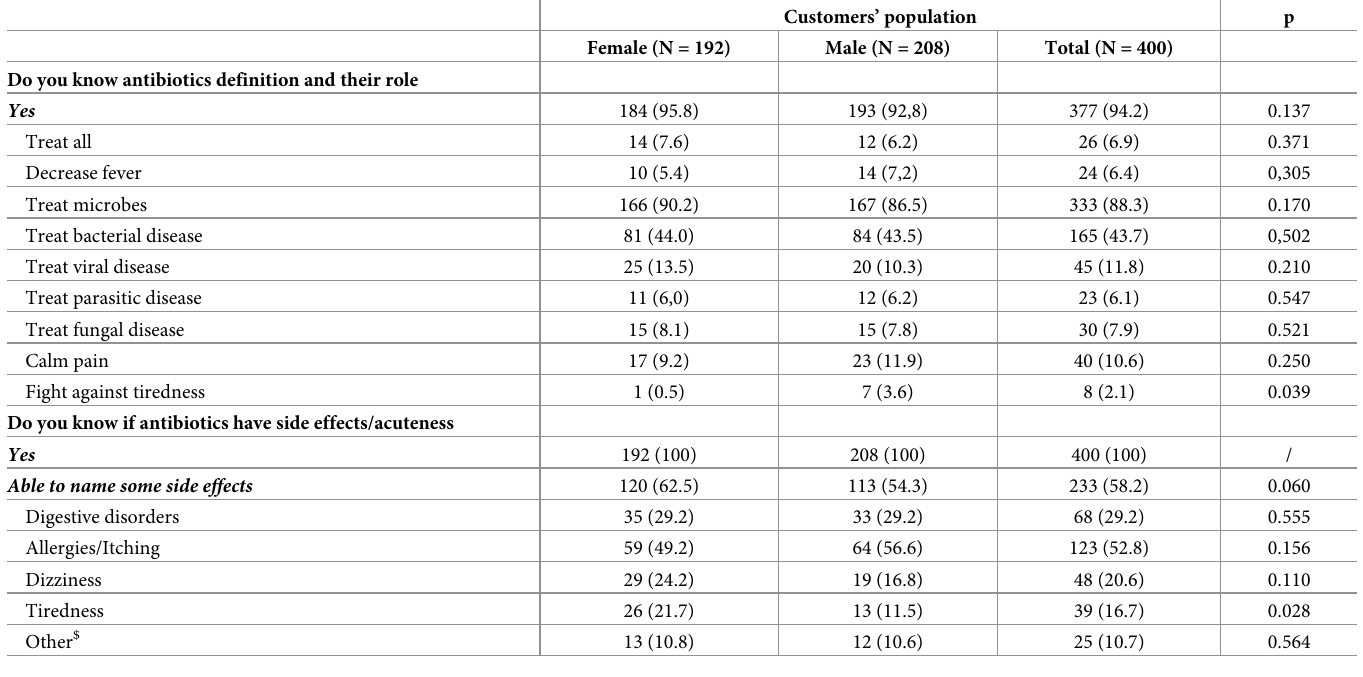
Table 2. Identification of Customers’ perceptions of antibiotic use � .